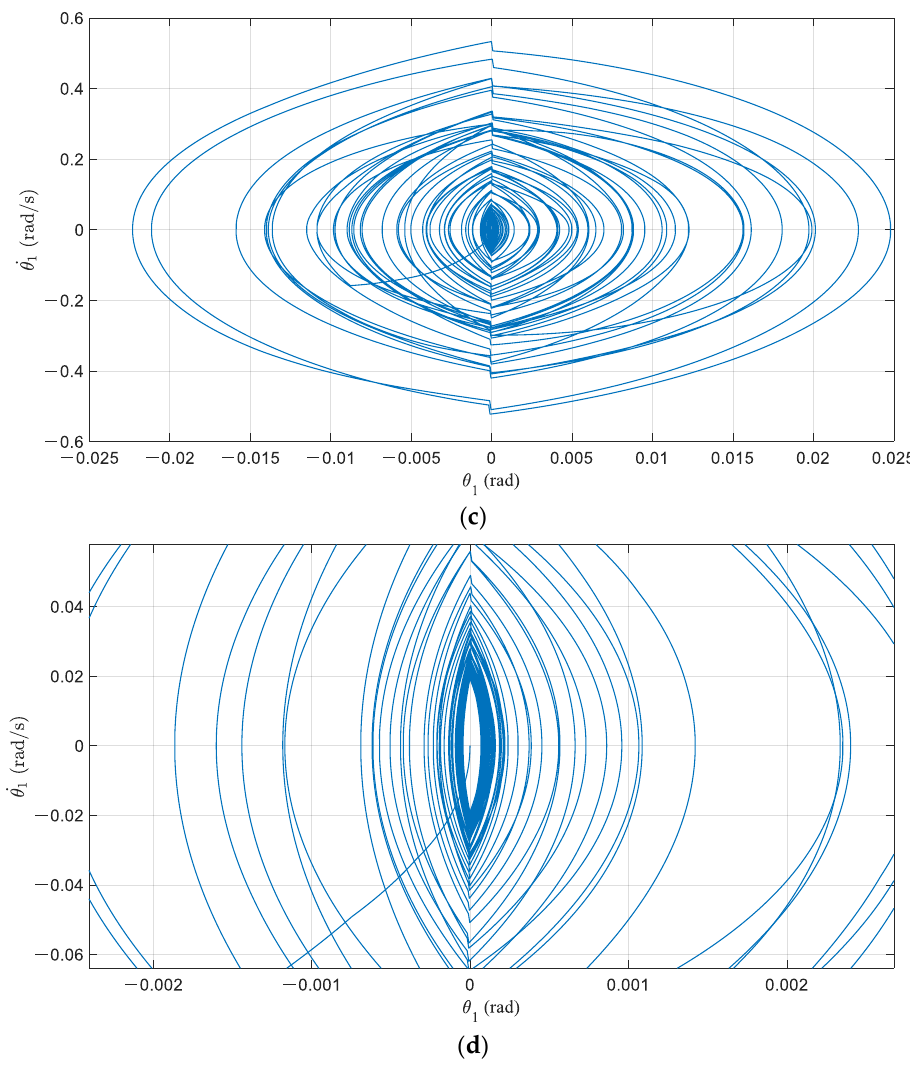
Figure 8. Calculation results of basic frame model under ER15: ( a ) time history of rocking rotation; ( b ) time history of angular velocity; ( c ) phase orbit; ( d ) limit cycle.